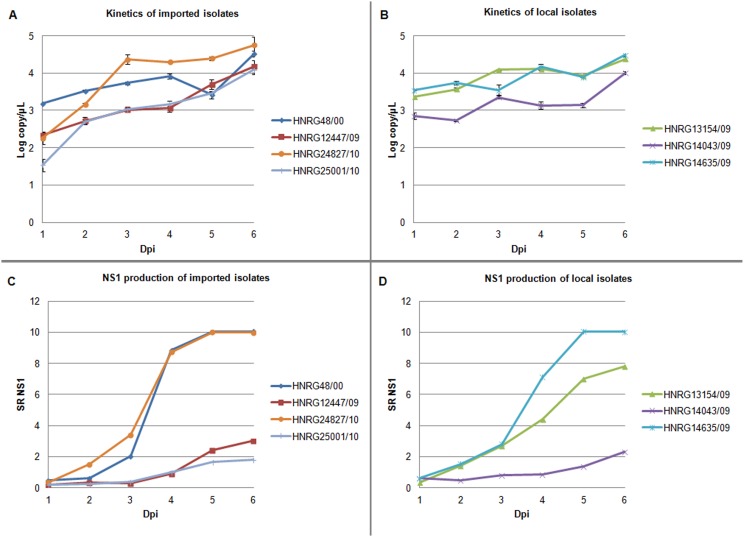
Viral RNA copies and NS1 production.Biological properties of imported (A and C) and local isolates (B and D). Viral loads are expressed as log copy/µL (A and B), points are mean values of two independent experiments. The SD are not seen in some of the points because they fall inside the symbol. NS1 production is expressed as absorbance at 450 nm/cut-off value (SR = sample ratio) (C and D). Dpi: days post-infection.